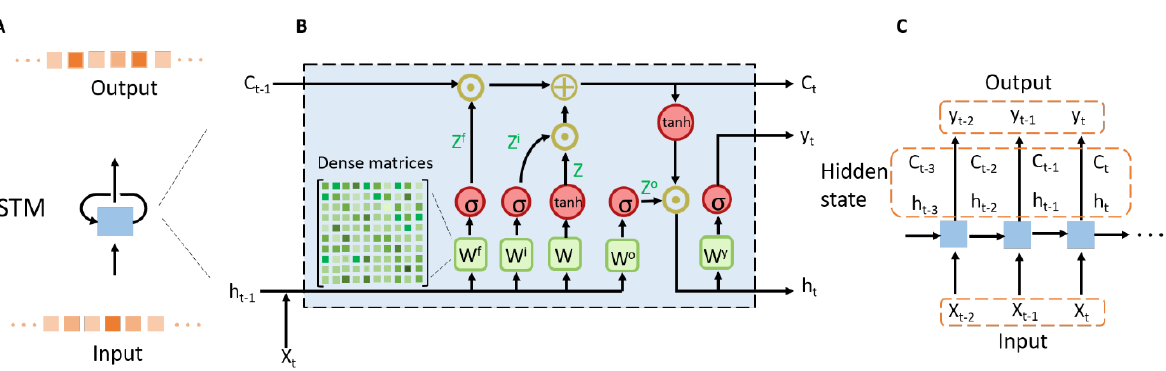
Figure 4. LSTM schematic. ( A ) Diagram of an LSTM cell. ( B ) Internal components of the LSTM cell, consisting of trainable dense matrices W f , W i , W, W o and W y . Activation functions for the hidden state and output are represented by σ and tanh. ( C ) Diagram of the directed graph of the LSTM cell. 𝑋 𝑡 is the input driver introduced in Table 1.